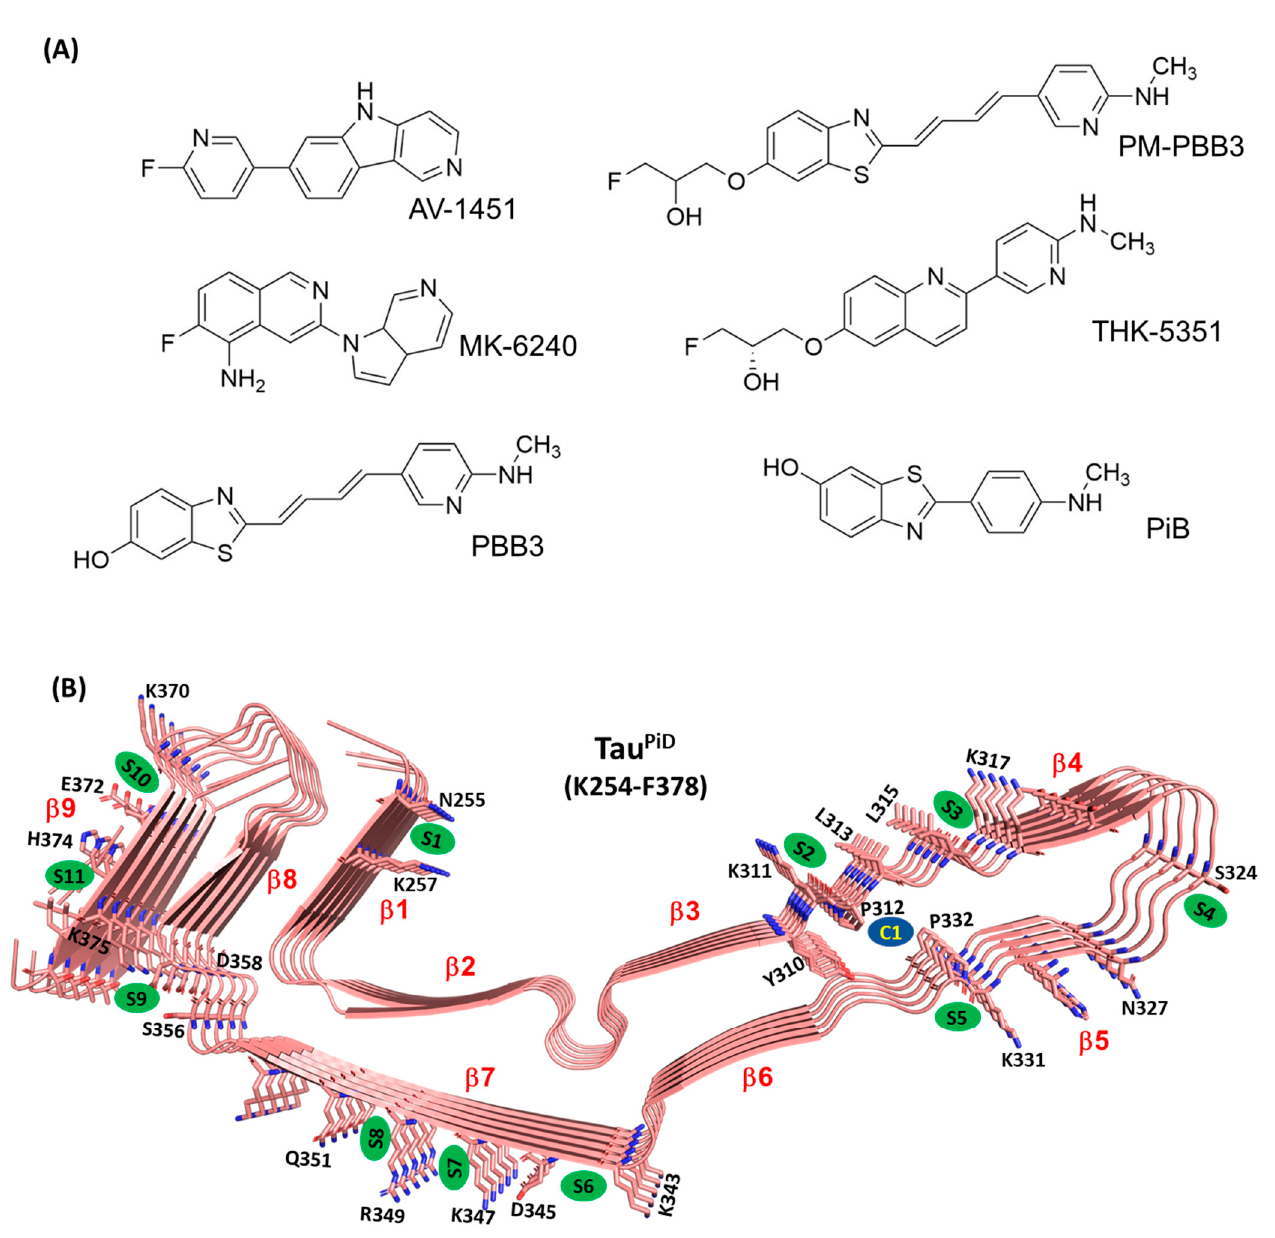
Figure 1. Positron emission tomography (PET) probes and their binding sites in tau predicted by molecular docking. ( A ) Chemical structures of unlabeled PET probes studied in this paper. ( B ) Secondary structure of tau filaments (K254 to F378) from Pick’s patients showing surface binding sites S1 to S11 (green), cavity site C1 (blue) and neighboring amino acid residues. Each β strand is labeled from β 1 to β 9.